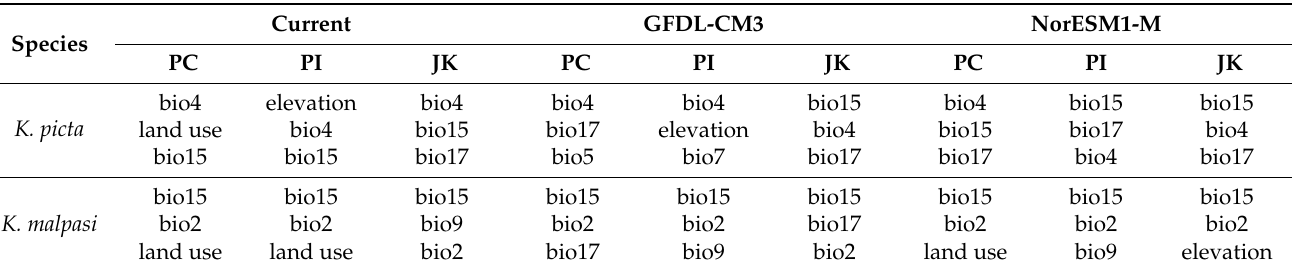
Table 3. Top three variable contributors based on percent contribution (PC), permutational importance (PI) and jackknifing (JK) to the Maxent models for current and future ecological niche models based on GFDL-CM3 and